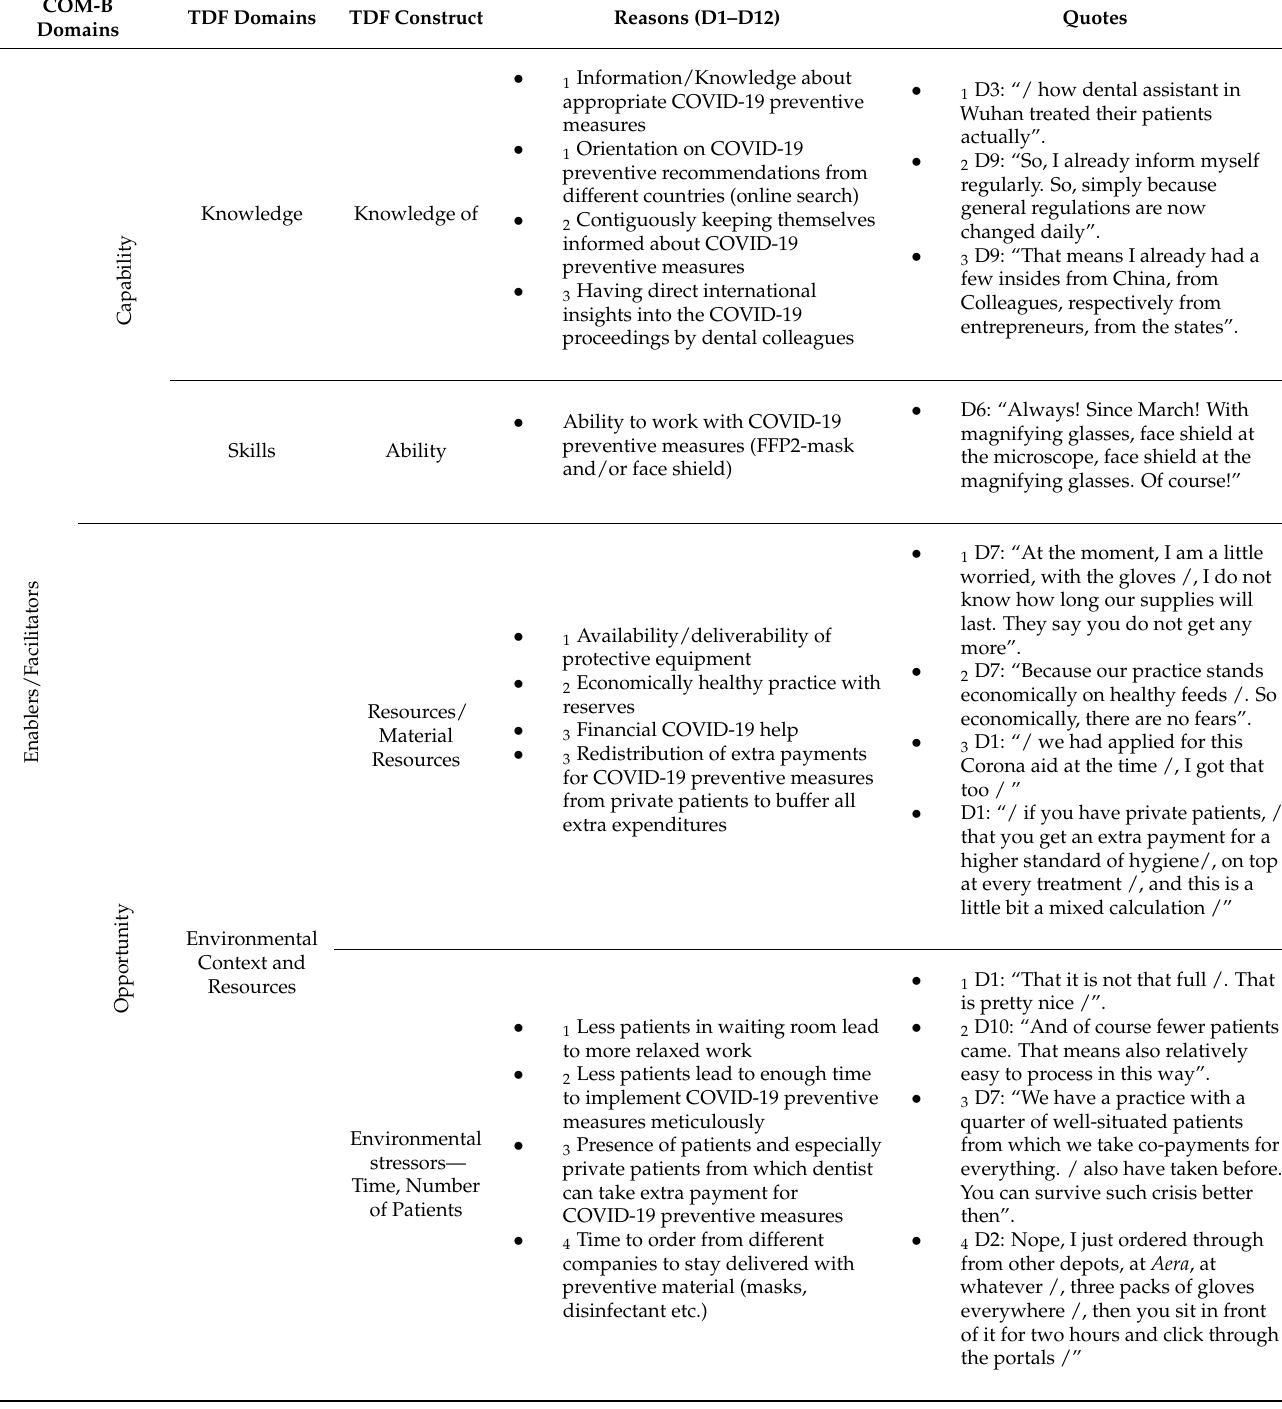
Table A1. Identified main enablers, conflicting themes and barriers for infection control measures of COVID-19. COM-B TDF Domains